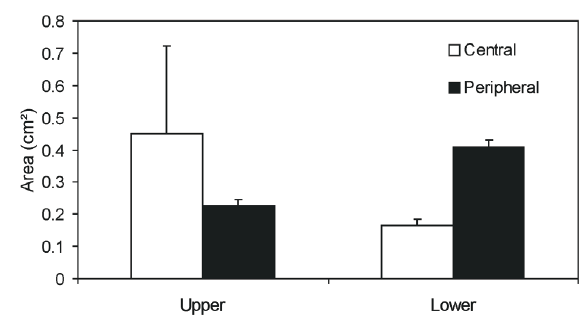
Fig. 3. – Colony area (mean + standard error) of multiserial encrust- ing bryozoans on central and peripheral zones of upper and lower valves.